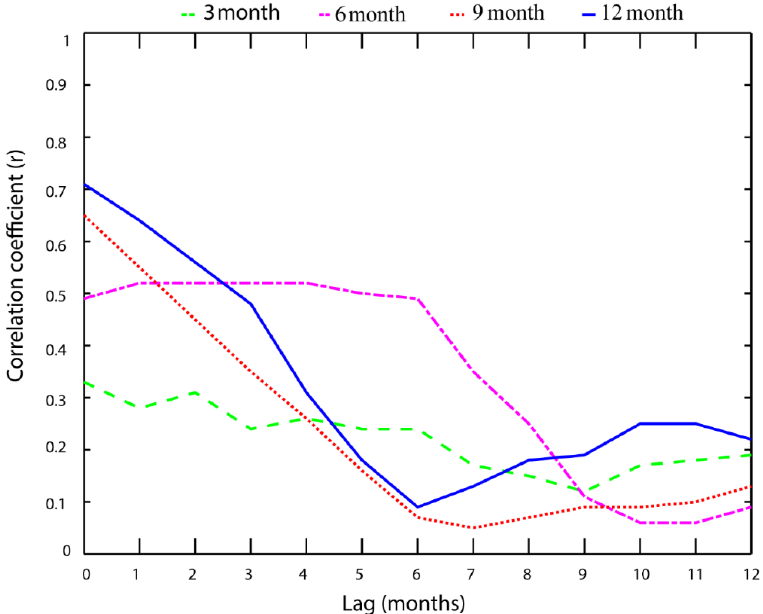
Figure 7. Correlation coefficients between RDI and SRI at time lags ranging from 0 to 12 months.